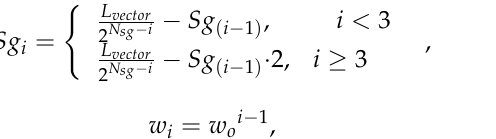
Figure 6. Complete block diagram of the proposed identification system for closed-loop identification.